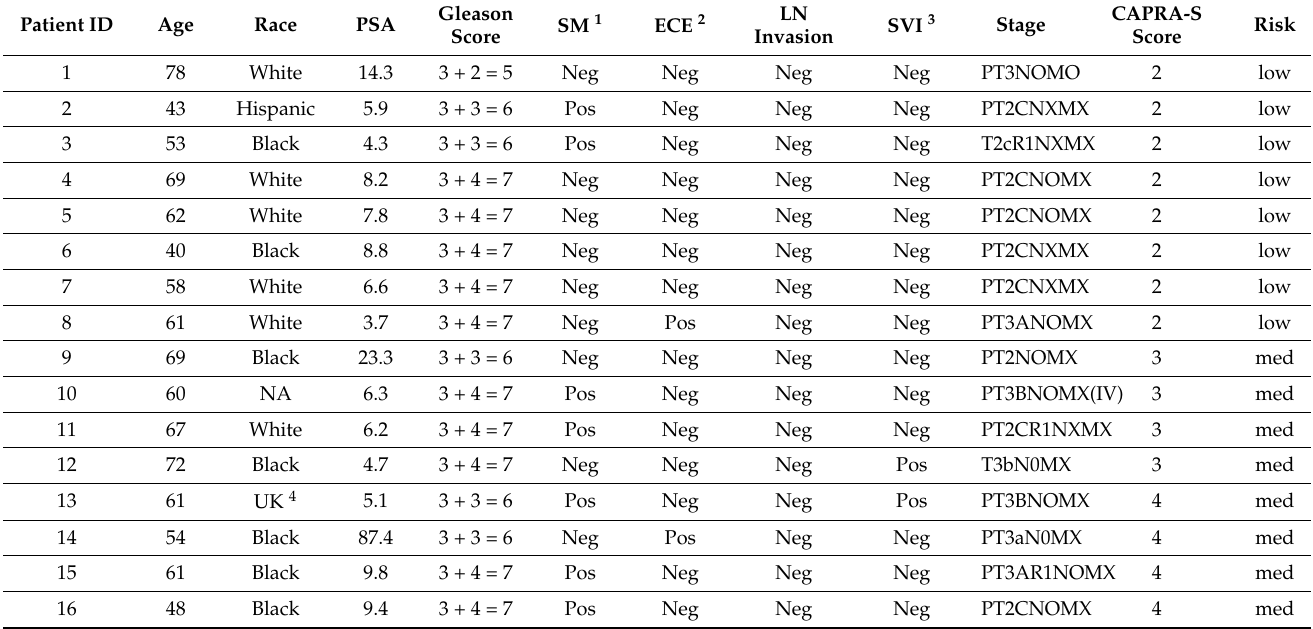
Table 1. Selected characteristics of